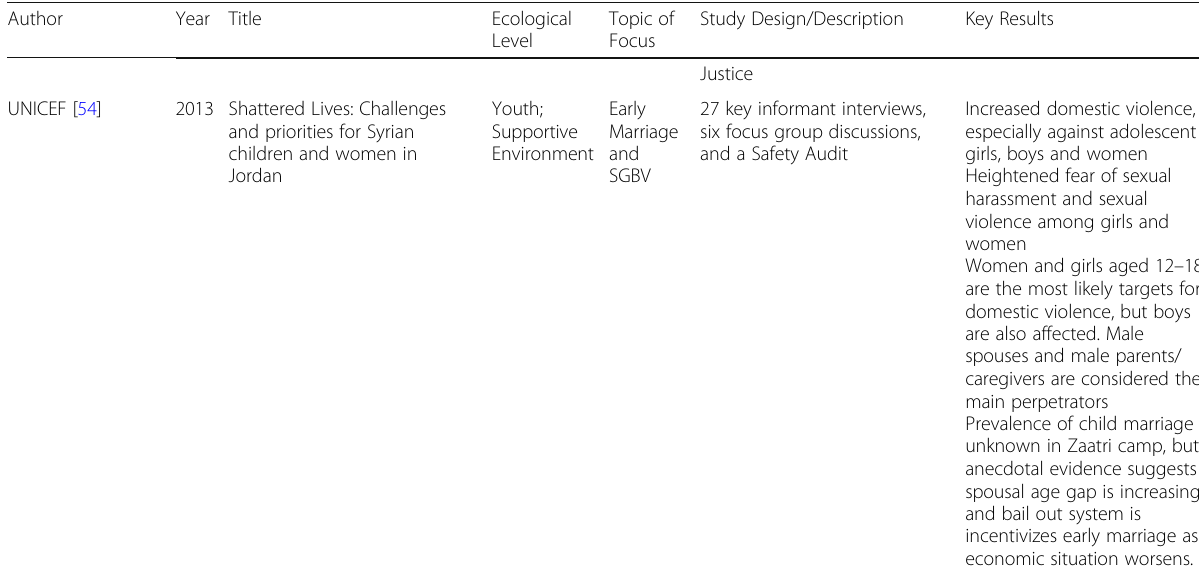
Table 1 Summary of the 27 documents included in the analysis according to ecological level and topic of focus pertinent to sexual- and gender-based violence and early marriage among youth in Jordan (Continued)